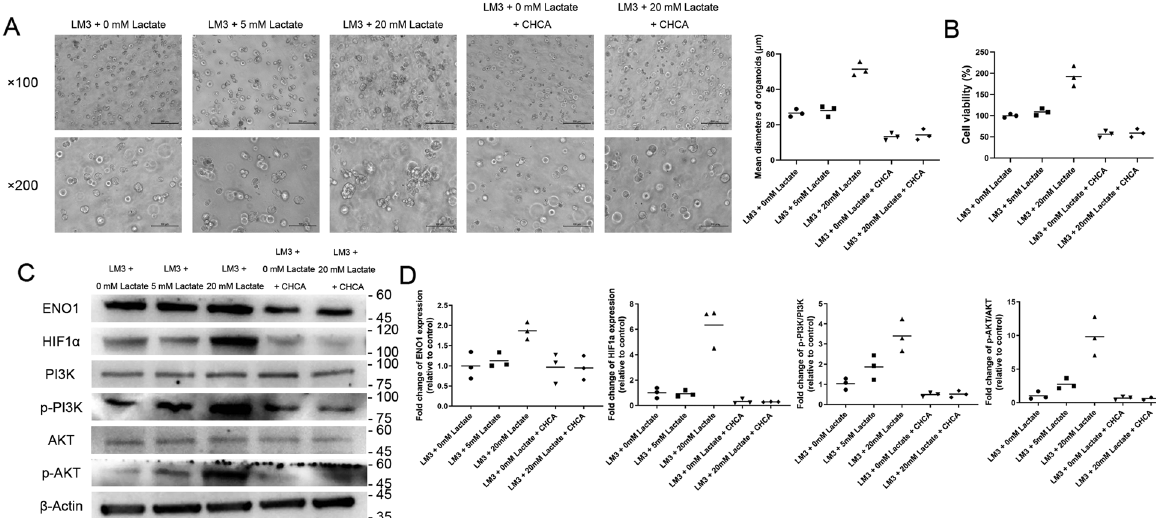
Fig. 1 Lactate promotes the growth of LM3 organoids via the ENO1/HIF1 α pathway. A Bright- fi eld images of LM3 organoids treated with different concentrations of lactate or CHCA. Scale bars in ×100 row refer to 200 μ m and scale bars in ×200 row refer to 100 μ m. B Viability of LM3 organoids treated with different concentrations of lactate or CHCA. C Immunoblot showing bands corresponding to ENO1, HIF1 α , PI3K, p-PI3K, AKT, p-AKT, and β -actin. D Quanti fi cation of the above proteins, p-PI3K/PI3K ratio, and the p-AKT/AKT ratio in the indicated groups. * P <